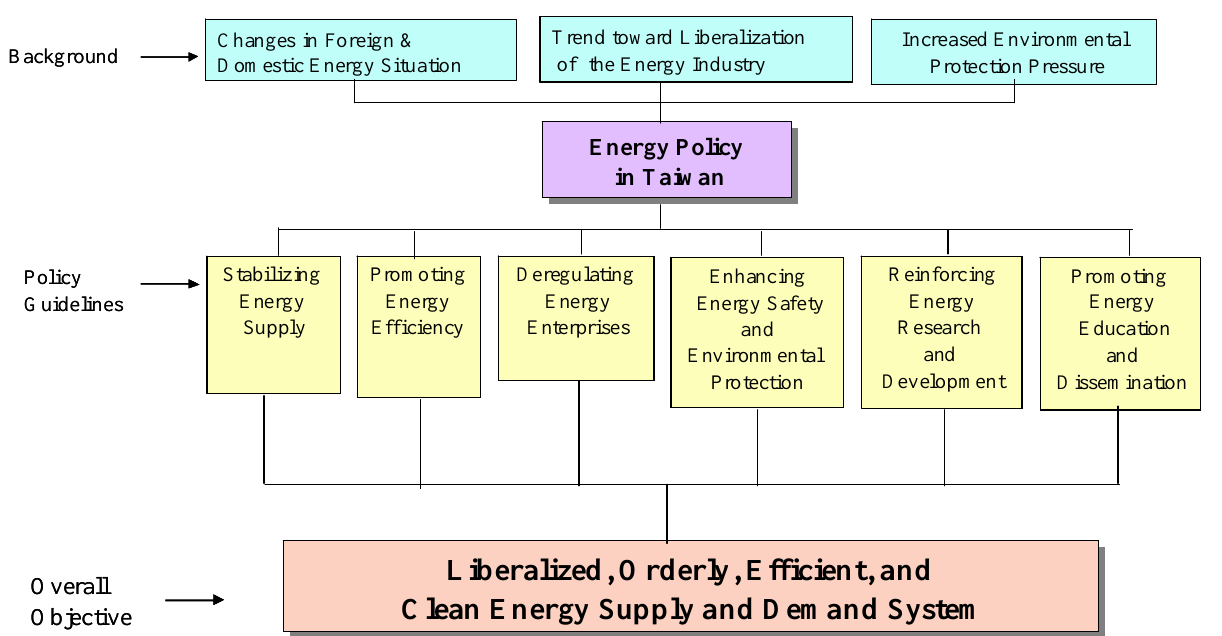
Figure 6. The framework of power market in Taiwan